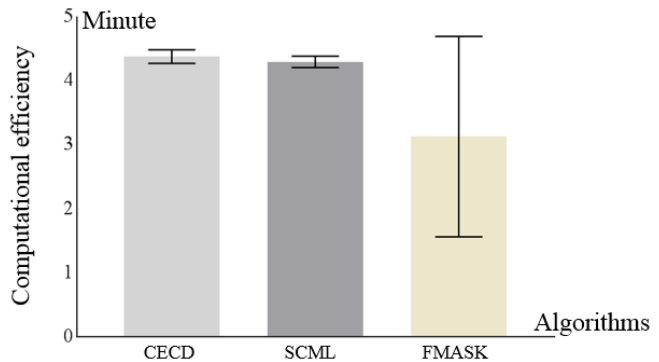
Figure 10. A bar graph plot of the computational efficiency of CECD, single classifier-based machine learning method (SCML), and FMASK with standard deviation error bars.